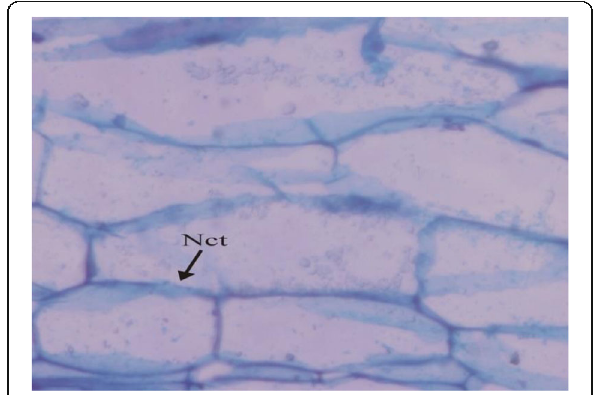
Fig. 7 Histopathological section of roots tissue of healthy tomato plants (longitudinal section, 40